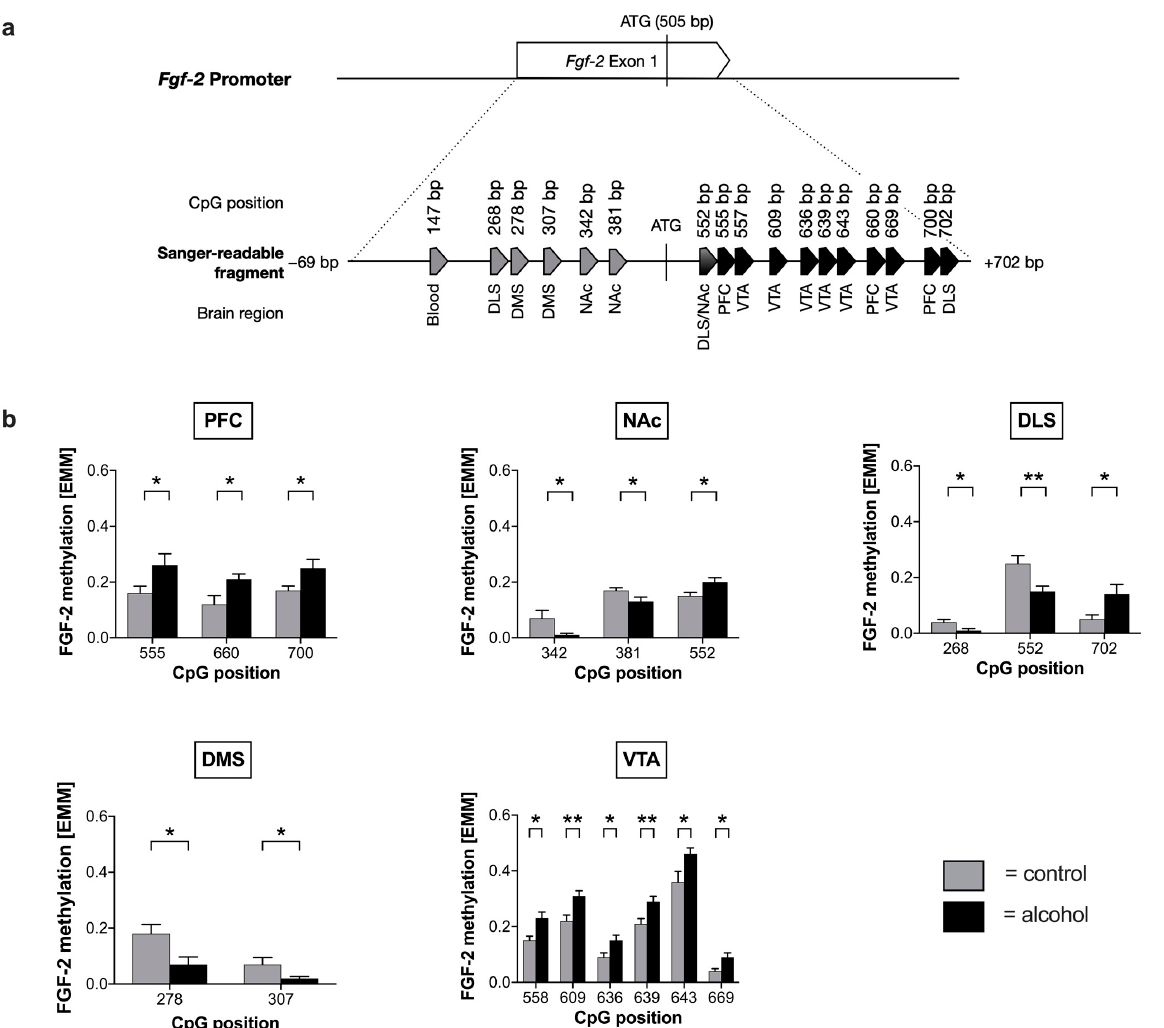
Figure 1. Alterations in the methylation of fibroblast growth factor 2 ( Fgf-2) after alcohol consumption. ( a ) Schematic representation of significant changes in the methylation pattern of the murine Fgf-2 promoter and exon 1. Chronic alcohol consumption induced hypomethylation in the Fgf-2 promoter in blood, dorsolateral striatum (DLS), and dorsomedial striatum (DMS). Increased methylation of CpG positions was observed downstream of ATG within exon 1, being most prominent for prefrontal cortex (PFC), ventral tegmental area (VTA), and DLS. No alterations were observed in the substantia nigra (SNc). We used two-tailed t -tests to identify the significantly mapped different CpG positions (total = 17). Arrowheads indicate significant alterations ( p ≤ 0.05) in methylation rate (gray = hyper- methylation in the control group compared with alcohol-drinking mice; black = hypermethylation in the alcohol group compared with water-drinking control mice). ( b ) Methylation rate of significant CpG positions of the Fgf-2 promoter in PFC, NAc, DMS, DLS, and VTA tissue samples after chronic alcohol exposure. Data are represented as mean ± SEM (n = 10 biological replicates) with a two-tailed Student’s t -test, * p ≤ 0.05; ** p ≤ 0.01 compared with the control